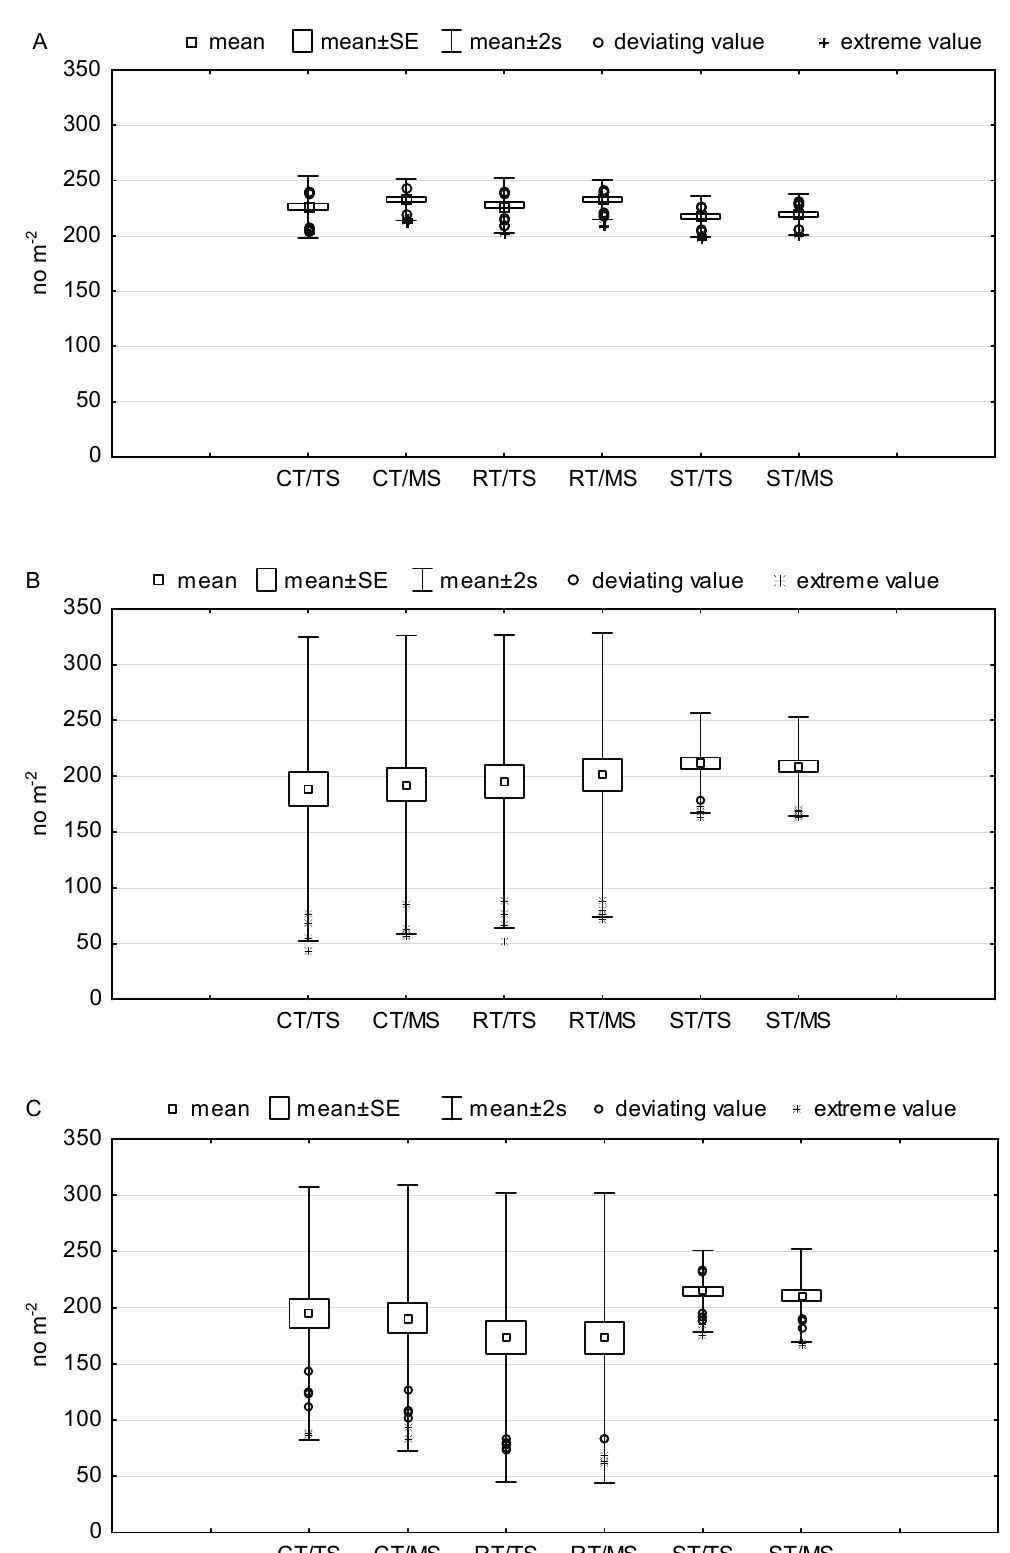
Figure 3. Variation in plant density in the first ( A ), second ( B ), and third ( C ) research year depending on winter wheat growing technology (CT—conventional, RT—reduced, ST—strip-till) and post-harvest treatments (TS—shallow tillage, MS—mulch).